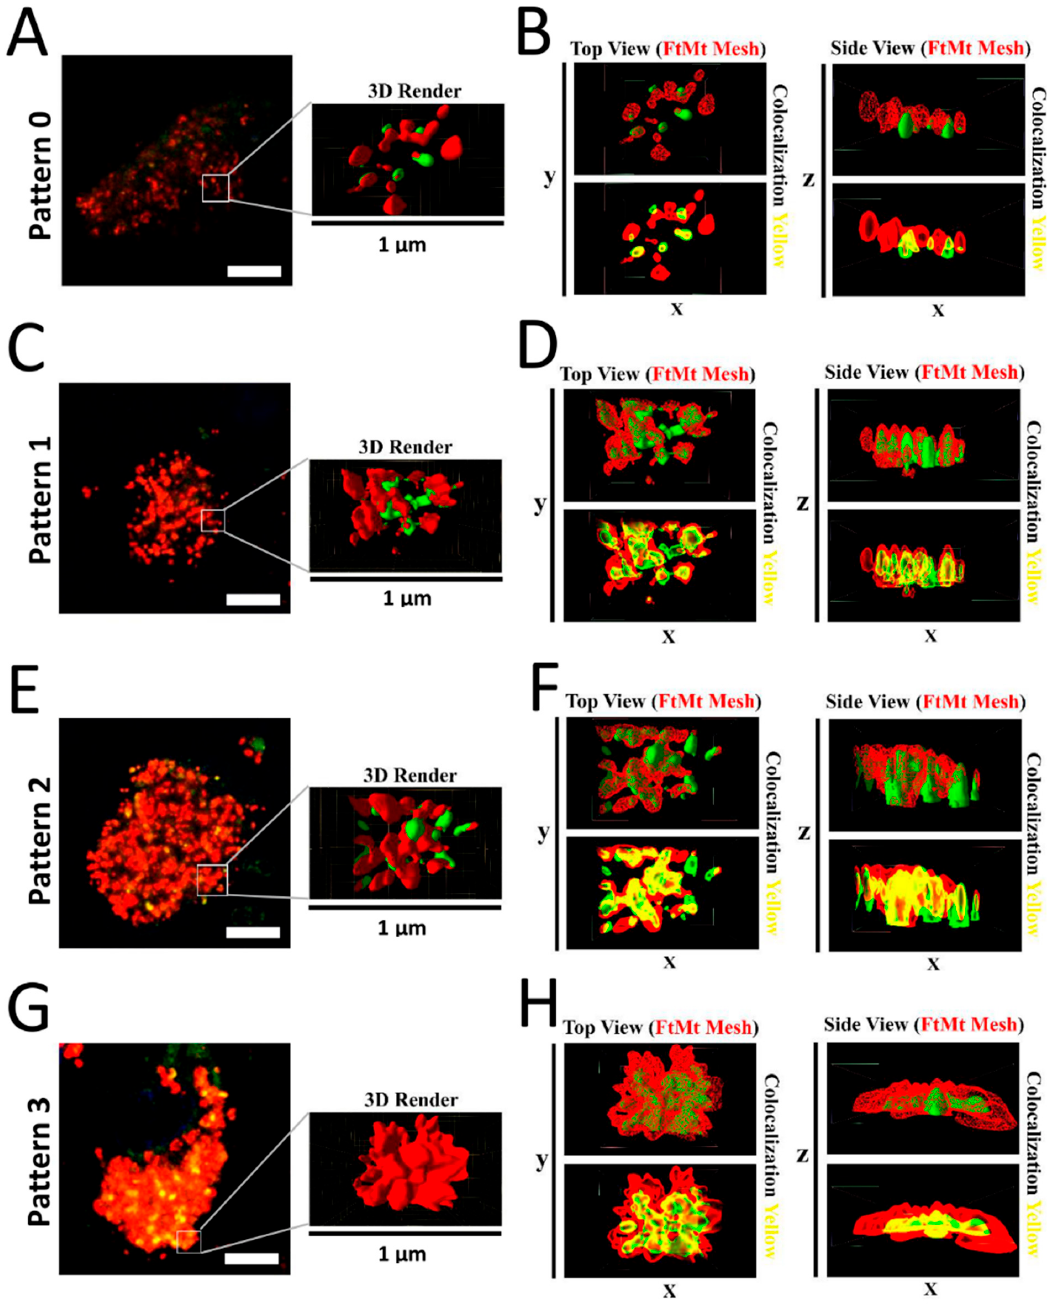
Figure 4. ( A ) Representative image of “pattern 0” (control-3 case). The 3D-rendered surfaces are shown on the right. ( B ) Top and side views of the rendered surface in A. Colocalization of FtMt-IR and LC3-IR was rare. ( C ) Representative image of “pattern 1” (PSP-1 case). The 3D-rendered surfaces are shown on the right. ( D ) Top and side views of the rendered surfaces in C. The FtMt-IR and LC3-IR were overlapping. ( E ) Representative image of “pattern 2” (PSP-1 case). The 3D-rendered surfaces are shown on the right. ( F ) Top and side views of rendered surfaces in E. The FtMt-IR and LC3-IR were overlapping. ( G ) Representative image of “pattern 3” (PSP-1 case). The 3D-rendered surfaces are shown on the right. ( H ) Top and side views of rendered surfaces in G. The LC3-IR was concealed by the FtMt-IR.